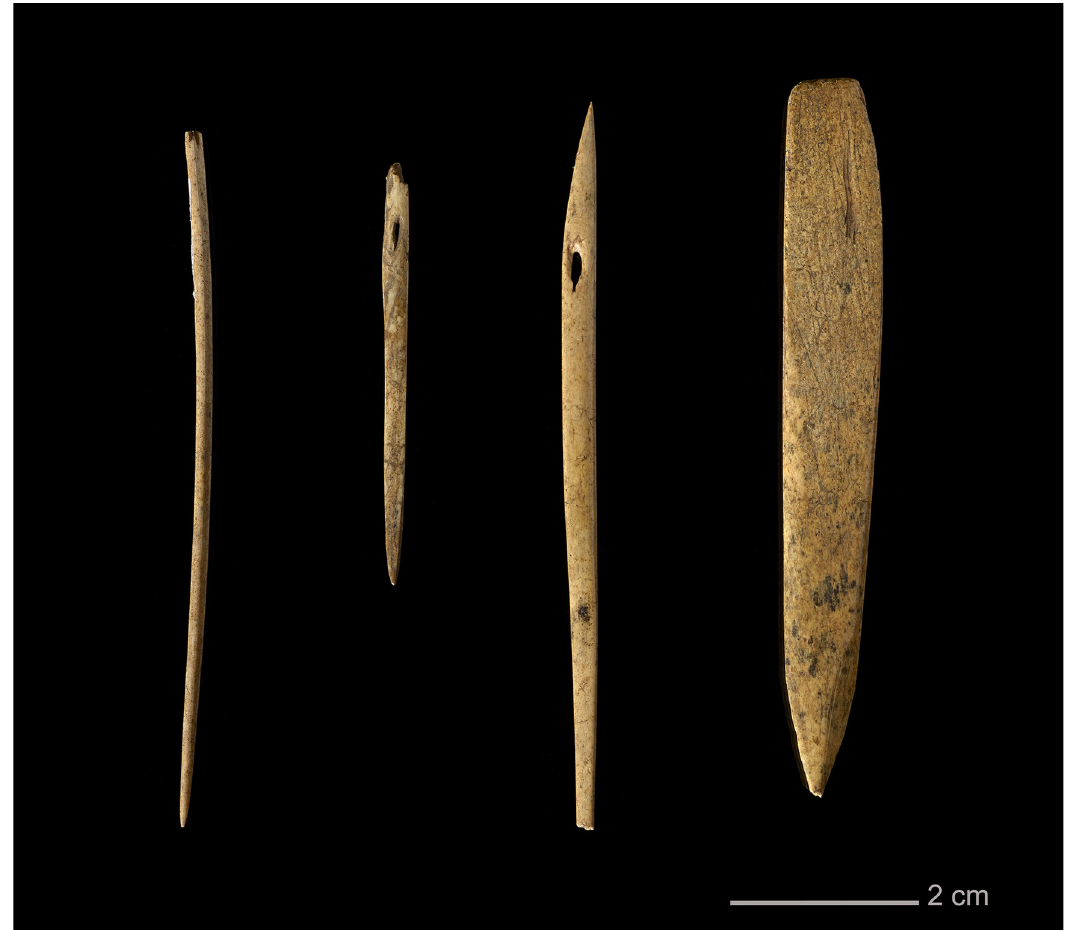
Figure 6: Bone sewing needles with perforated holes and a bone awl, all from Rissebávti/Gressbakken Nedre Vest house 4. Photo by M. Karlstad, UiT – The Arctic University of